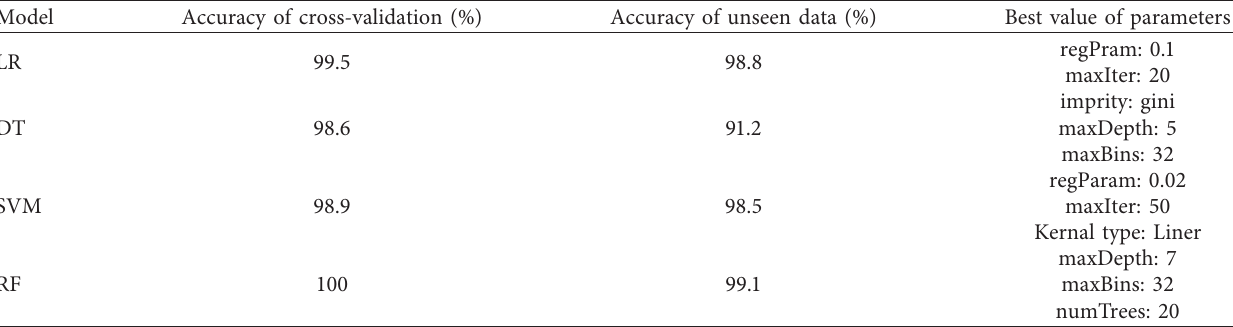
Table 4: Results of models were applied on the selected features by RFECV.